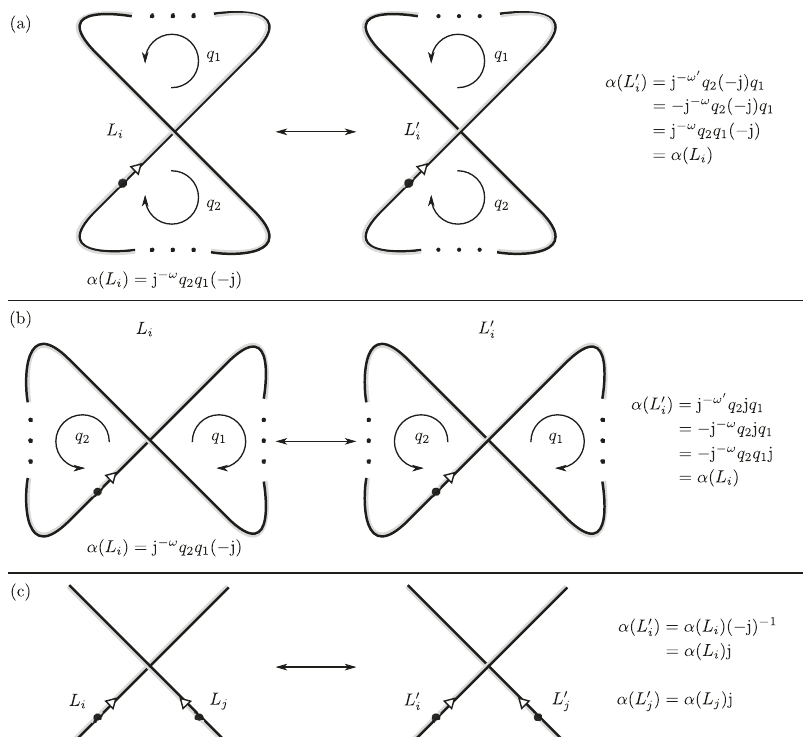
Fig. 10 Conservation of the colored invariant Q gray in topologically allowed strand crossings. By rotating the picture if necessary, one can assume that the black color of the bicoloring is on the right hand side when moving upwards along either of the strands of the crossing. The pictures ( a ), ( b ) and ( c ) depict the cases that can occur. In ( a ) and ( b ) the strands partaking in the crossing change are parts of the same loop L i ; note that the self-writhes of L i and L 0 differ by ±2. The difference between the two cases is that in ( a ), the quaternion q 1 anticommutes with j, because the path corresponding to q 1 passes i under an odd number of red and blue strands in total, whereas, for analogous reasons, in ( b ), q 1 commutes with j. The crossing change in ( a ) and ( b ) does not alter the linking number of L i with other gray loops, so Q gray remains unchanged. In ( c ), the strands are part of loops L i and L j . Note that α ð L 0 unchanged.